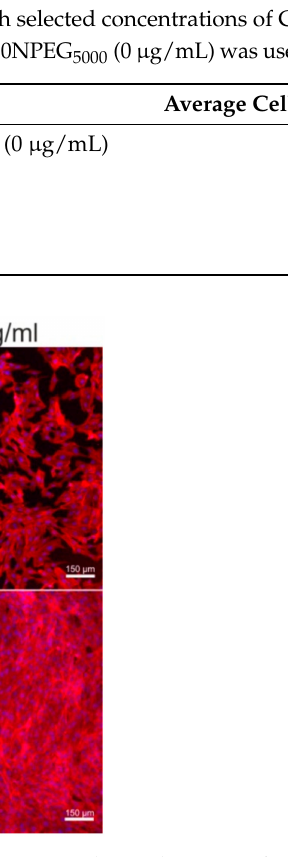
Figure 8. The confocal laser scanning microscope (CLSM) images showing osteoblast (hFOB 1.19 cell line, ATCC CRL-11372 TM ) nuclei (blue fluorescence) and F-actin filaments (red fluorescence) after 2- and 4-days incubation with C60NPEG 5000 solution at concentration of 7.81 µ g/mL. Culture medium without C60NPEG 5000 (0 µ g/mL) was used as a control. Magnification 100 × , scale bar equals 150 µ